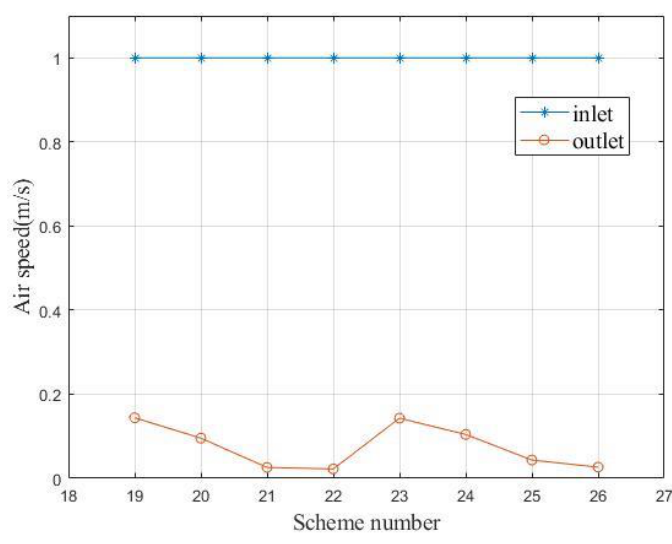
Figure 21. The air speed at the inlet and outlet based on the number of inlets and outlets.